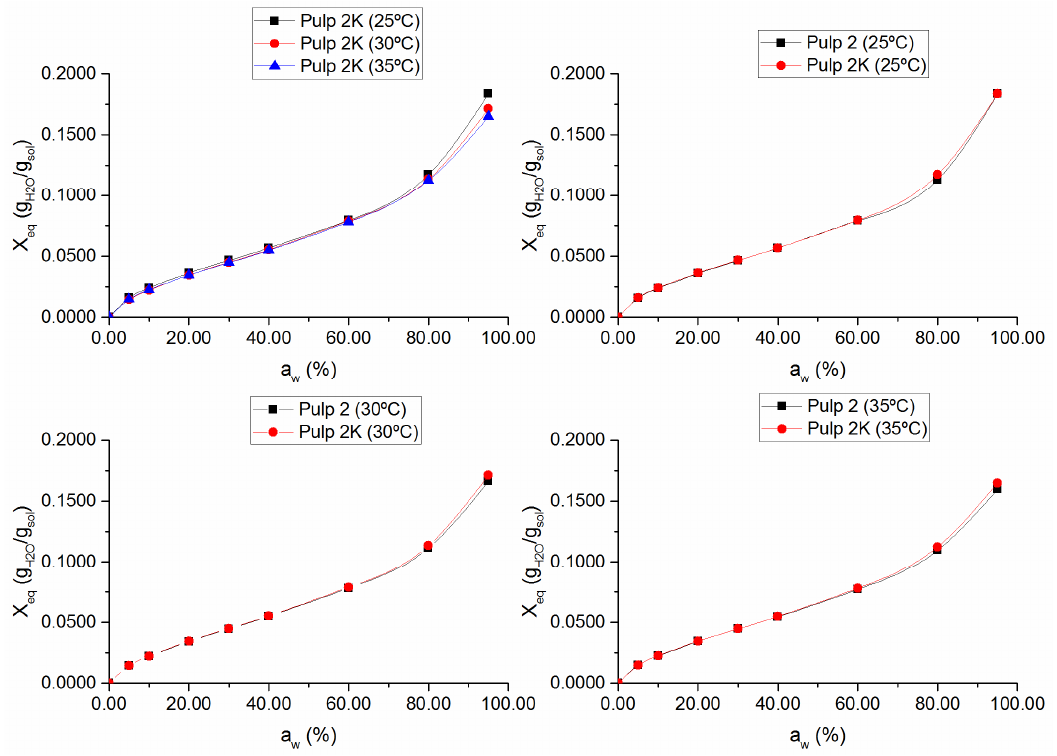
Figure 2. Sorption isotherms of fluff pulps with knots ( 2K pulp) and without knots ( 2 pulp) at 25, 30, and 35 °C.